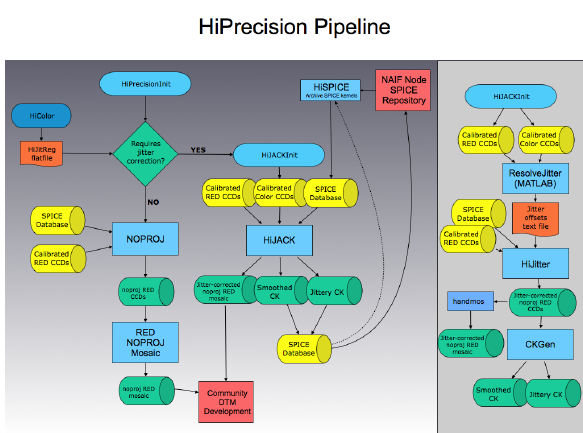
Figure 3. HiPrecision processing subsystem flowchart showing the two branches that produce the NoProj, geometrically corrected products, and the HiJACK branch that additionally performs jitter correction. The HiJACK branch is detailed in the right panel. Calibrated products are pulled from intermediate steps in the HiRISE image processing